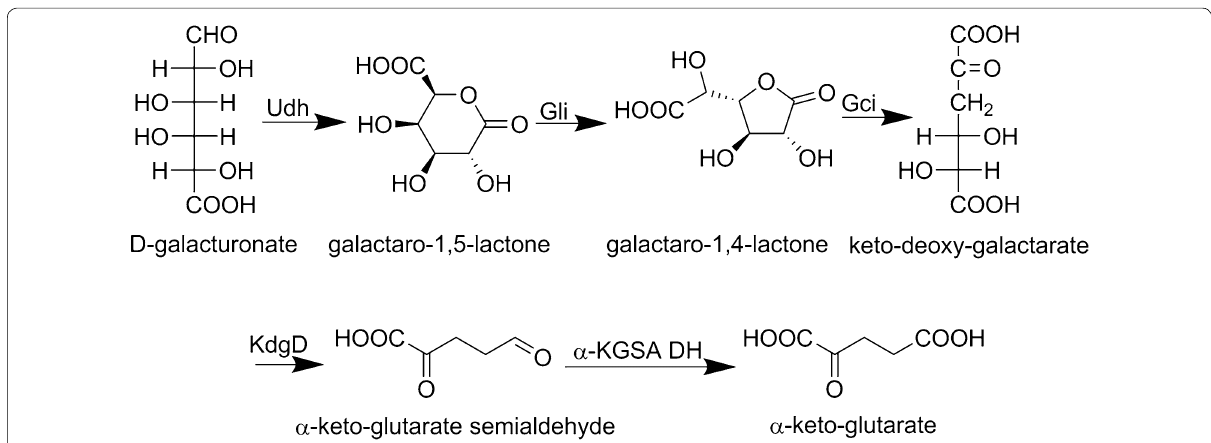
Fig. 3 The bacterial pathway for oxidative galacturonate catabolism. Udh: d -galacturonate dehydrogenase EC 1.1.1.203; Gli: galactarolactone isomerase EC 5.4.1.4; Gci: galactarolactone cycloisomerase EC 5.5.1.27; KdgD: 5-dehydro-4-deoxy-glucarate dehydratase EC 4.2.1.41; α-KGSA DH: 2,5-dioxypentanate dehydrogenase EC